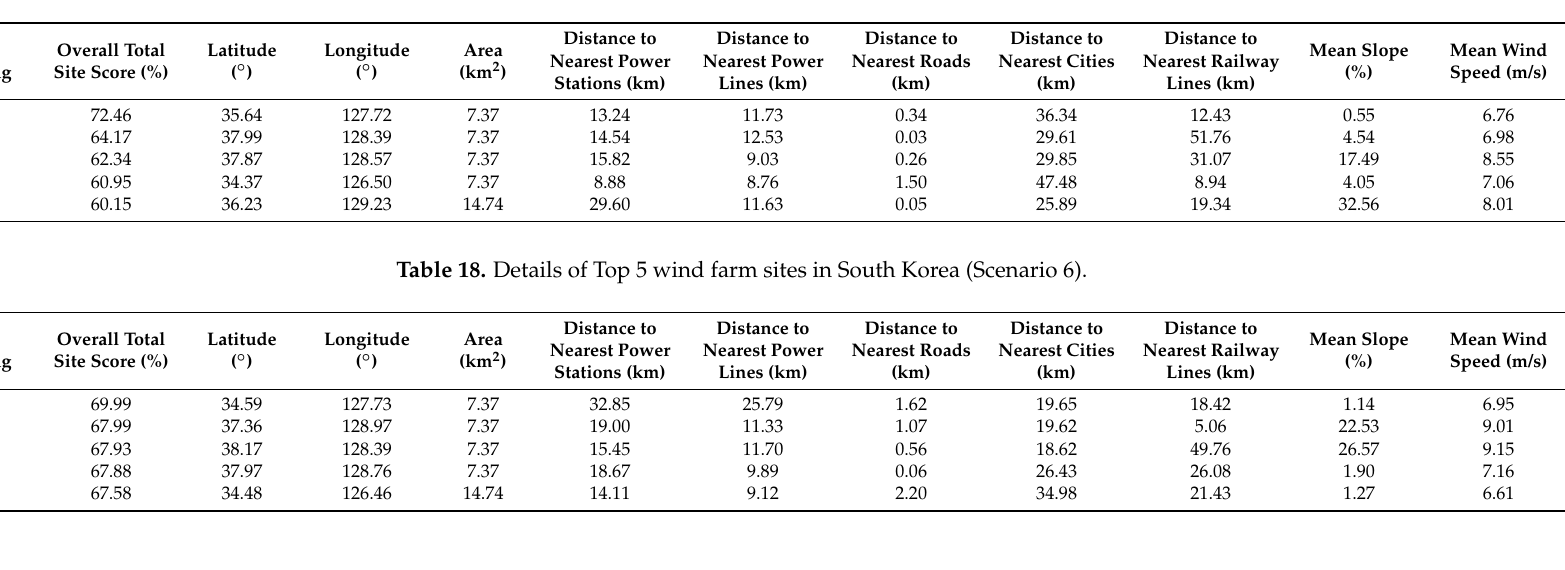
Table 17. Details of Top 5 wind farm sites in South Korea (Scenario 5).